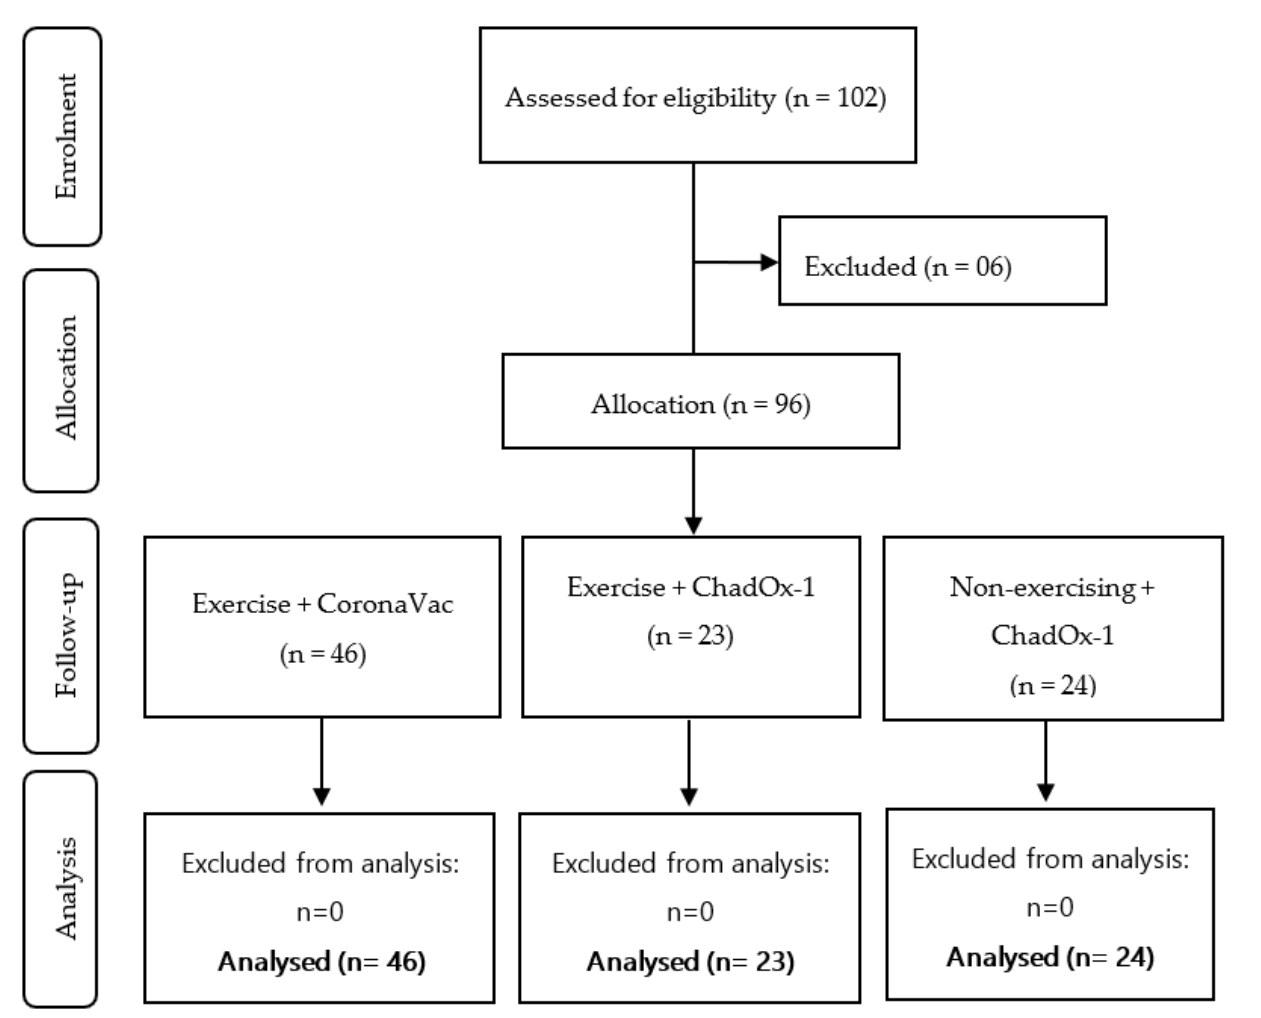
Figure 2 . Flowchart of the study design. Figure 2. Flowchart of the study